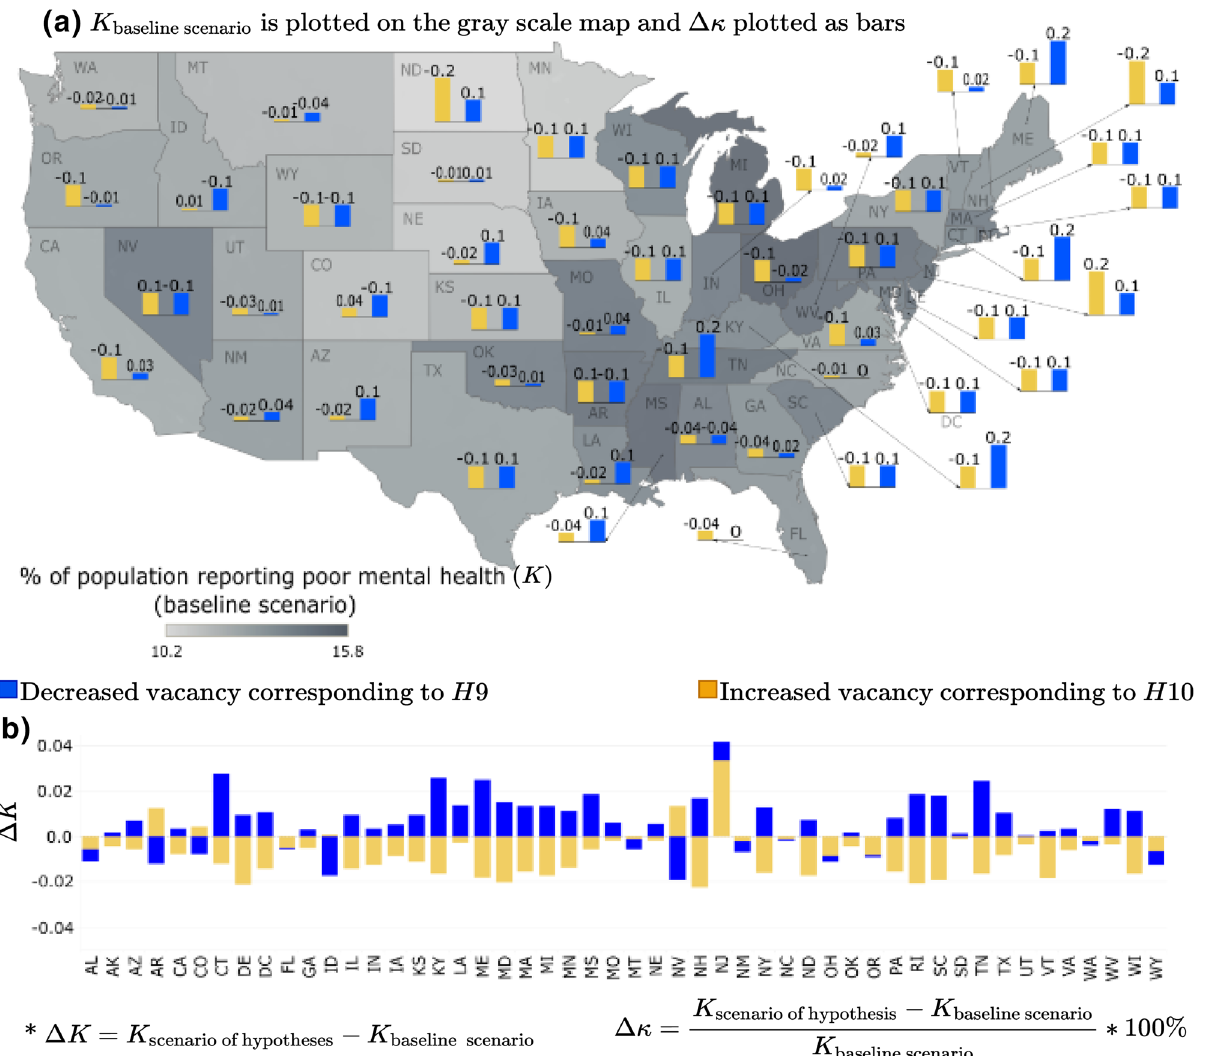
Figure 7. Housing vacancy scenario for % of adults aged > 18 years reporting poor mental health for > 14 days ( K ): ( a ) �κ is plotted as the bars and K for base line scenario is plotted as gray scale intensity on the US map; and for ( b ) (cid:31) K is plotted. The maps are created using Tableau 2021.2 (Tableau 2021.2 New Features) and Adobe Illustrator (Software and services for creative business teams | Adobe Creative Cloud for bars representing the projected change expressed as a percentage of the baseline estimate with the underlying K base case scenario depicted in the map as gray scale intensities. In the subsequent sections, we discuss the result of the sensitivity of K to different categories of independent variables.